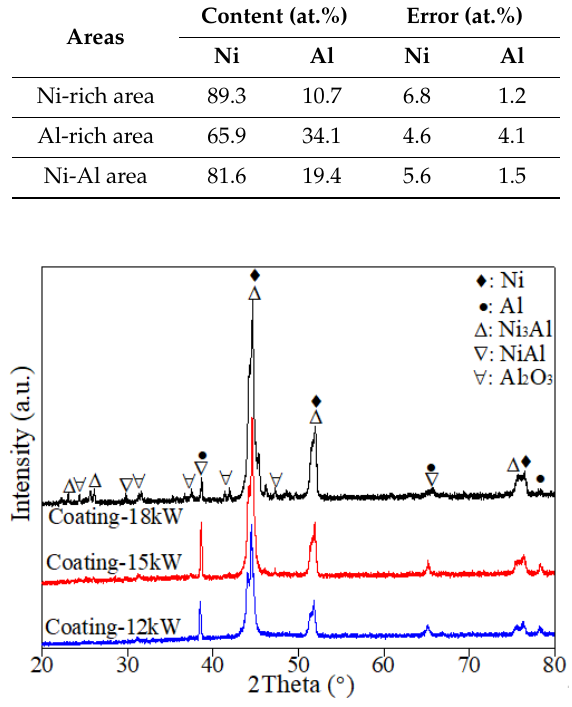
Figure 7. XRD spectrum of Ni80Al20 coatings under different spraying powers.